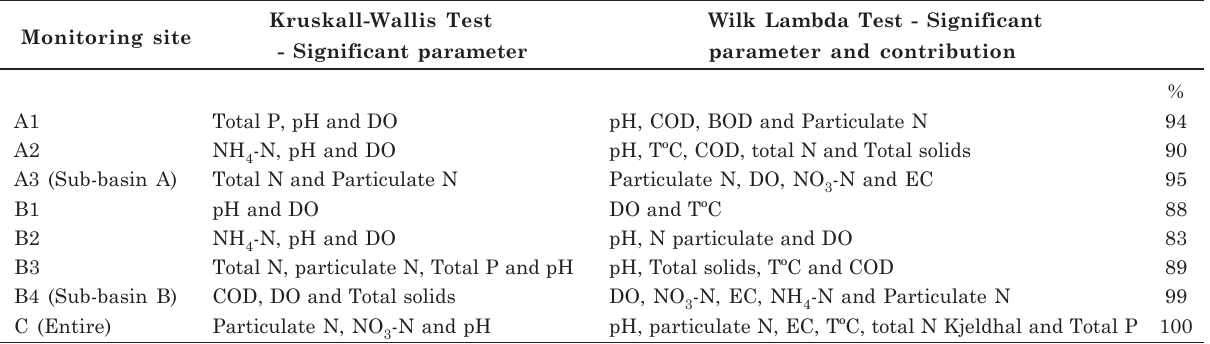
Table 10. Seasonal difference for the Kruskall-Wallis and Wilk Lambda tests for each monitoring site in the Campestre